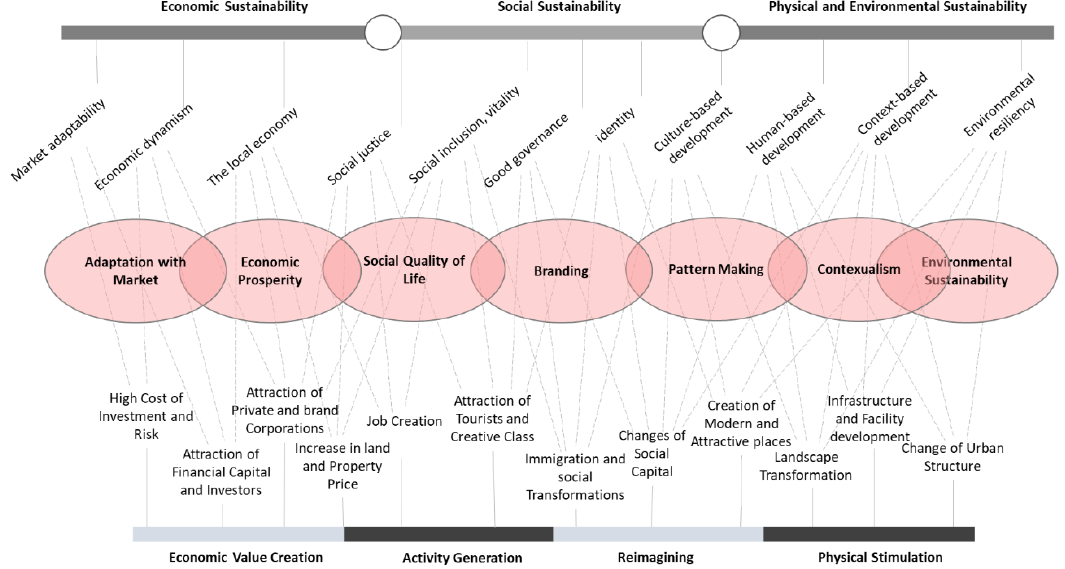
Figure 2. Conflict map between sustainability goals and the probable catalytic impacts of an urban